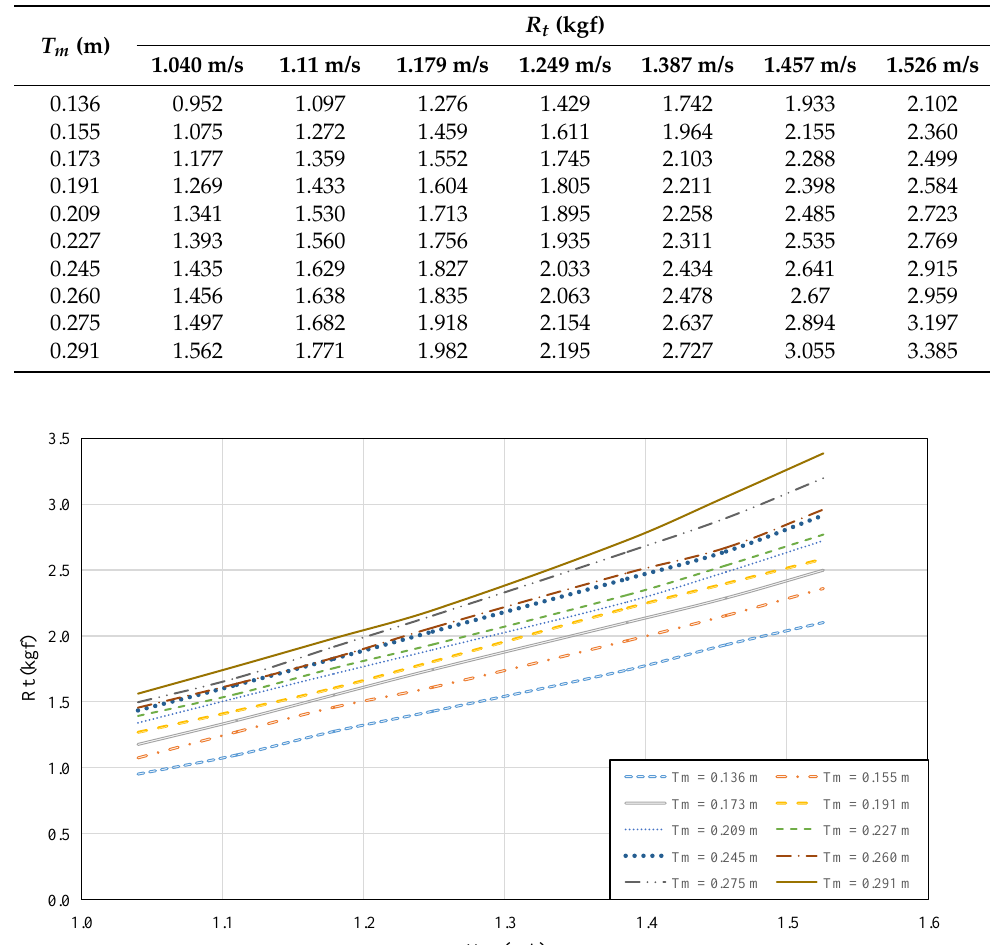
Table 4. Model ship resistance at different speeds and drafts.